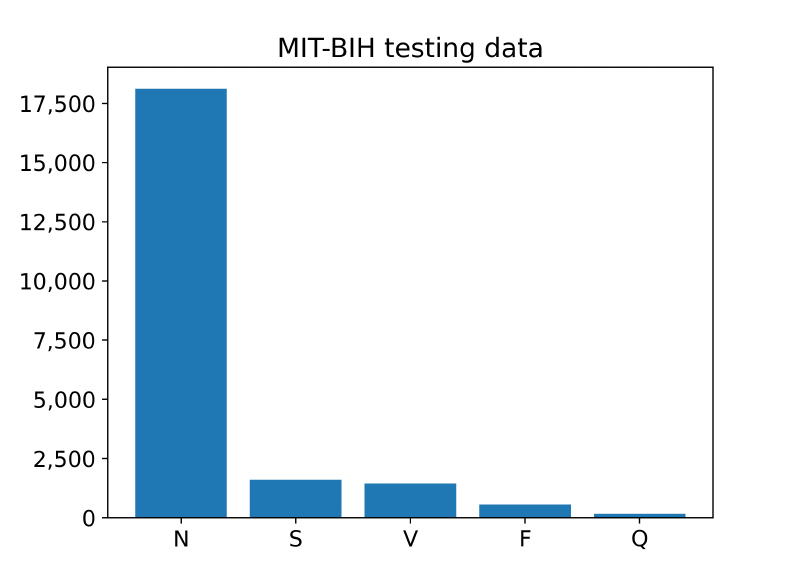
Figure 7. The number of images of each class in testing PhysioNet MIT-BIH Arrhythmia data. The number of normal and abnormal images of the PTB Diagnostics dataset are summarized in Figure 8. The number of normal images is greater than 10,000, whereas the number of abnormal images is less than 4000.